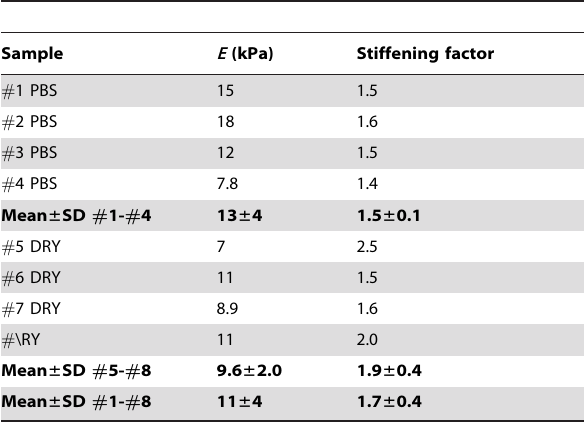
Table 7. Young’s moduli E (kPa) and stiffening factors across the entire